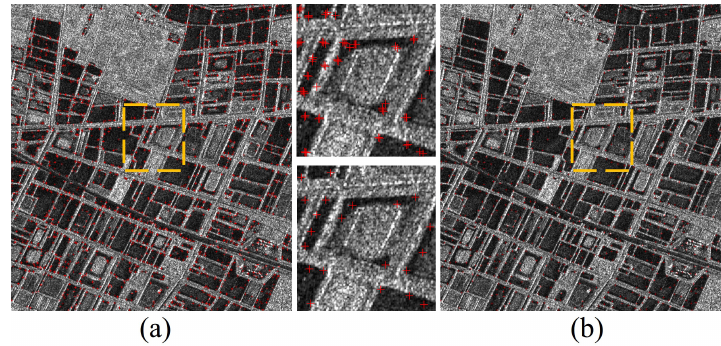
Figure 9. Comparison of SAR-Harris and NMS-SAR-Harris for keypoint extraction: ( a ) keypoints obtained by SAR-Harris algorithm; ( b ) keypoints obtained by improved SAR-Harris algorithm.The latter improves the problem of points repetition in the